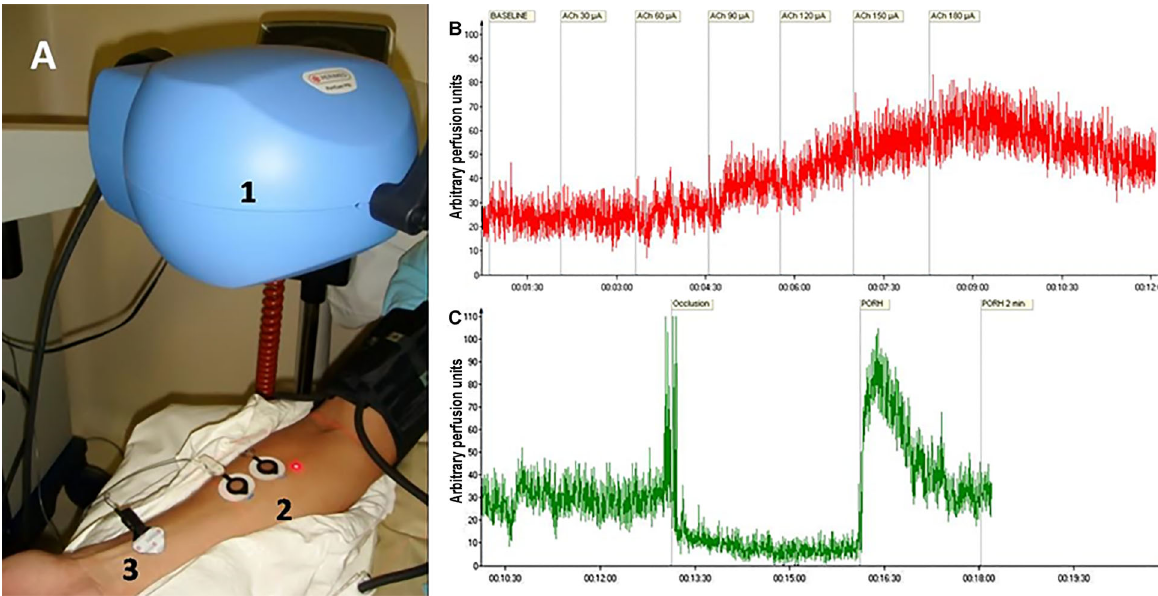
Figure 1. A , Photograph of the experimental set up used in the assessment of skin microvascular perfusion using laser speckle contrast imaging coupled with iontophoresis of vasodilator drugs. 1) Imager head, 2) drug-delivery iontophoresis electrodes, 3) dispersive electrode (see Material and Methods). B , Representative examples of the effects of the transdermal iontophoretic delivery of cumulative doses of acetylcholine (ACh) on skin blood fl ow during the iontophoresis of ACh (2% w/v) using increasing anodal currents of 30, 60, 90, 120, 150, and 180 m A applied in 10-s intervals spaced 1 min apart. C , skin microvascular blood fl ow during post-occlusive reactive hyperemia